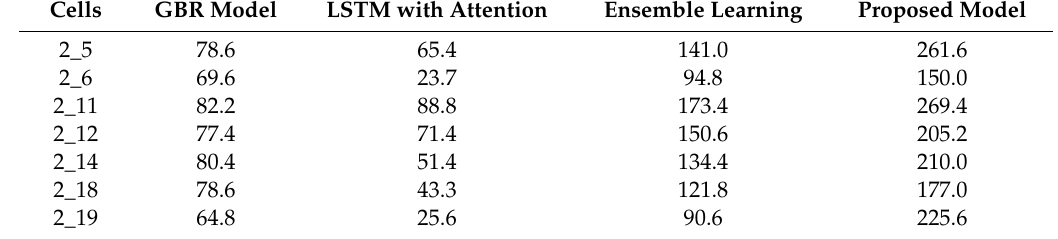
Table 4. The computation time of different models (in seconds).